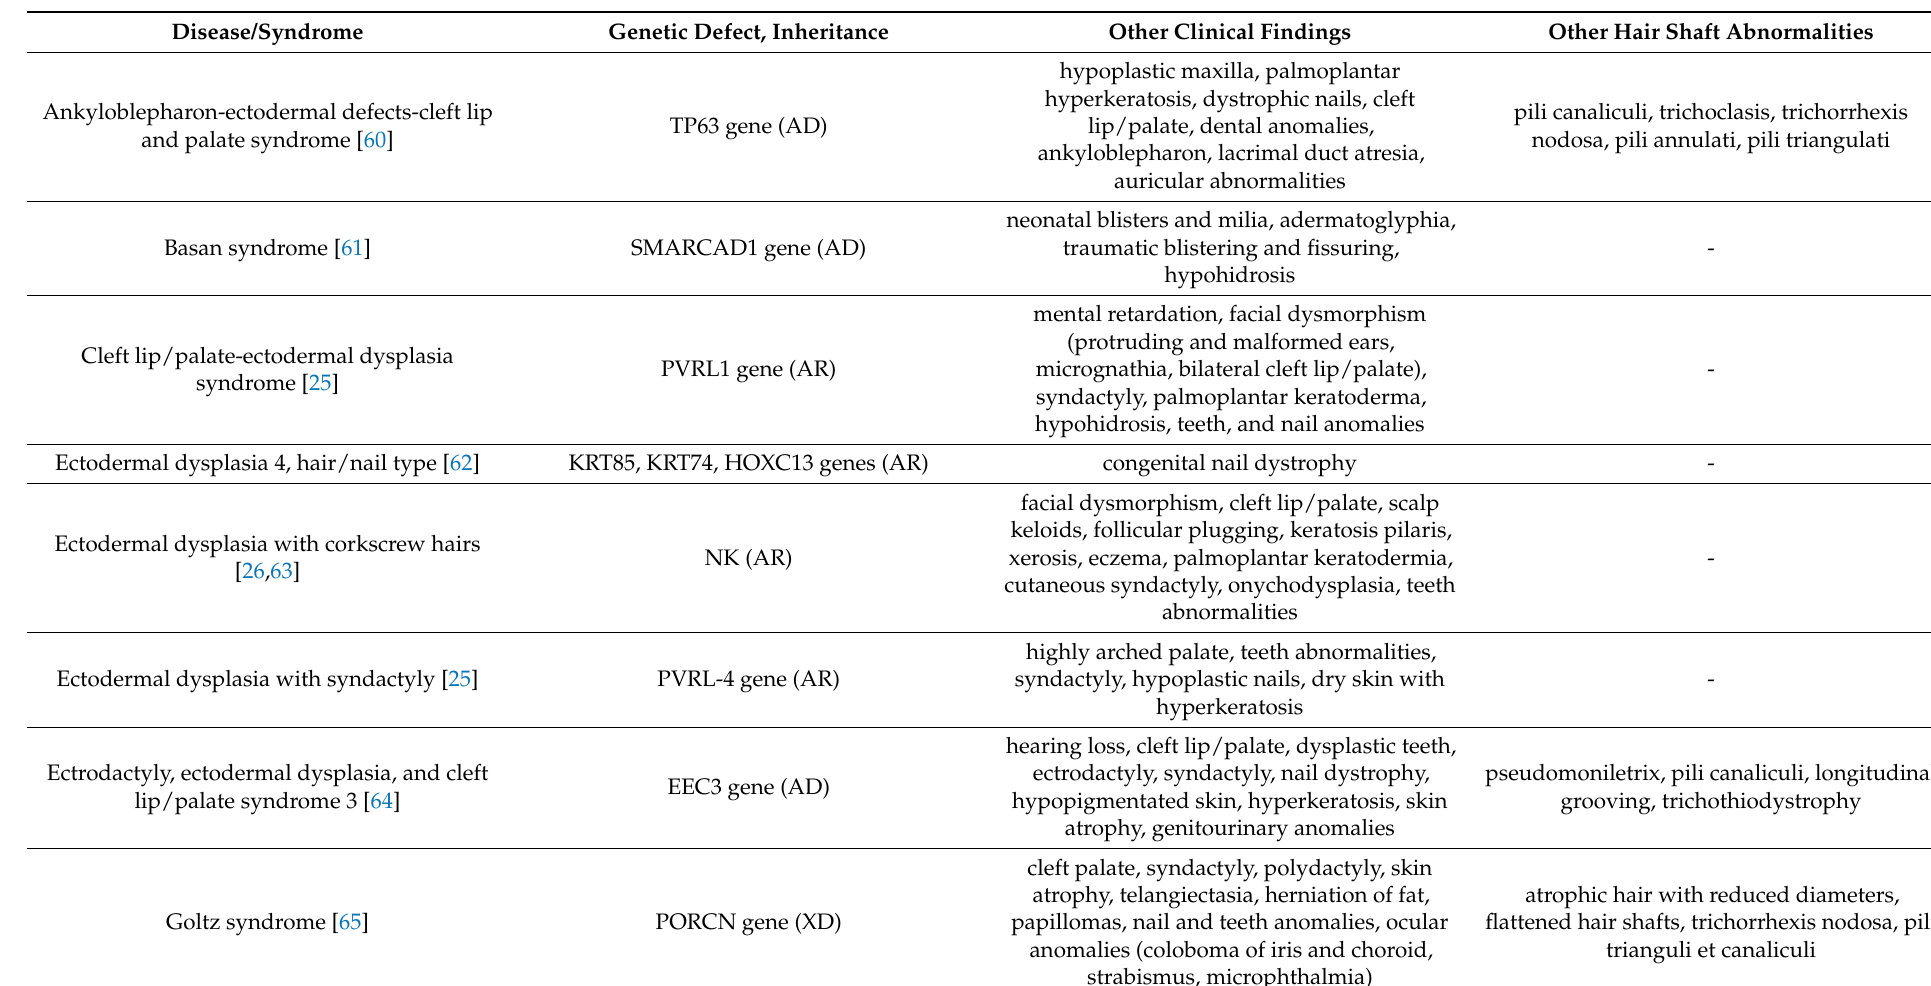
Table 2. Pili torti in ectodermal